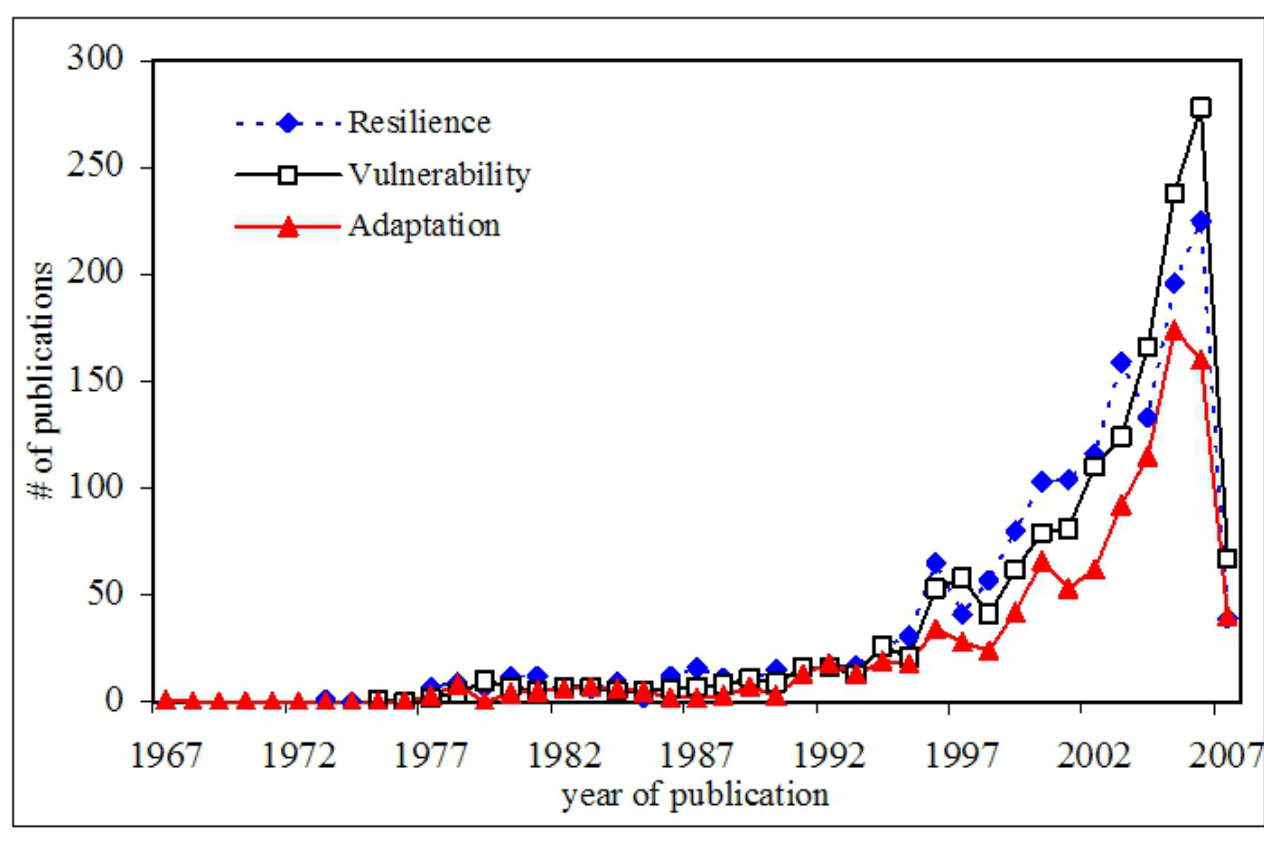
Fig. 1. Number of papers published in the three knowledge domains per year. Data for 2006 and 2007 are